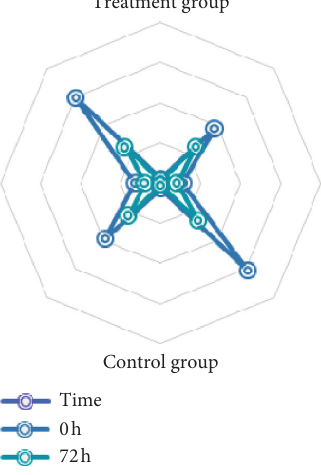
Figure 4: Hepatorenal